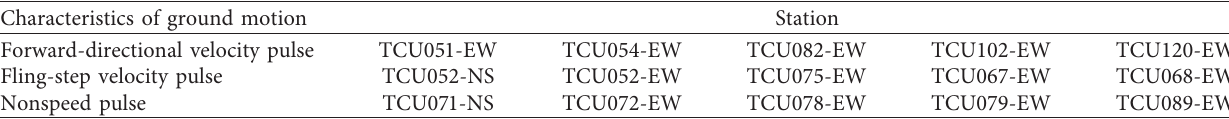
Table 4: The selected ground motions with velocity